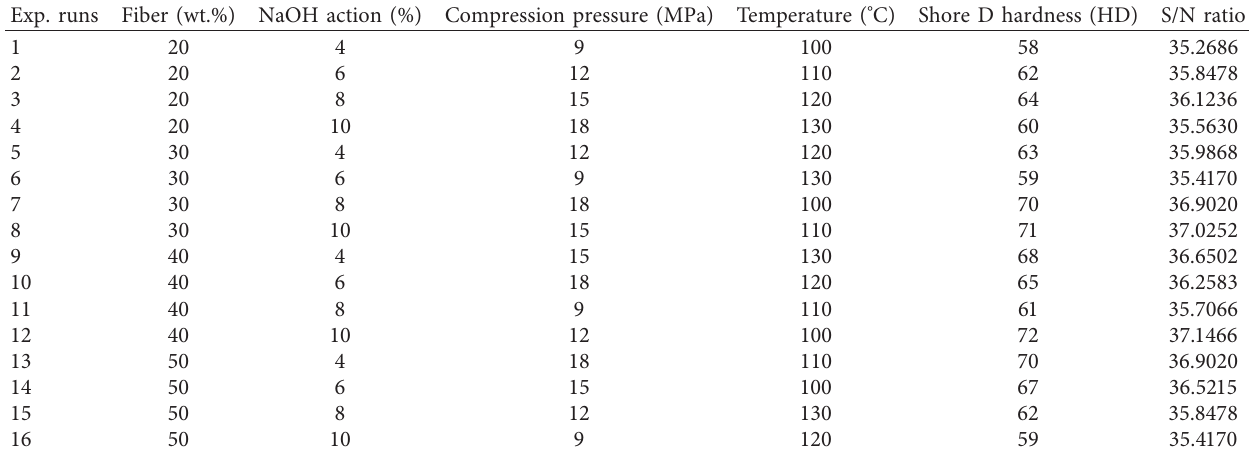
Table 8: The shore D hardness with the influence of parameters.